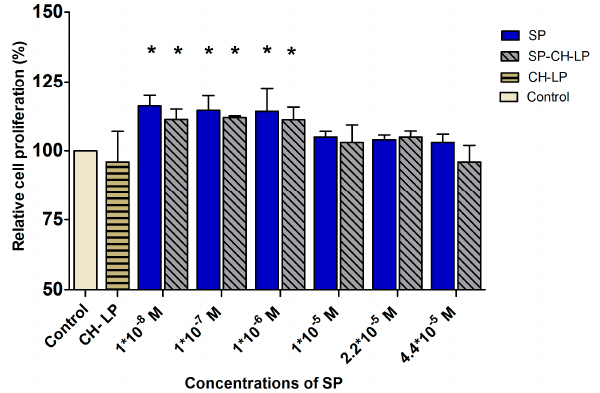
Figure 7. Effect of varying concentrations of free and liposome-encapsulated substance P on relative cell proliferation in HaCaT cells, as measured by BrdU colorimetric assay over 24 h. (Data represent the mean average ± standard deviation, of three independent biological experiments.) Cell culture medium (DMEM) with supplements was used as control; stars on bars represent significant differences with respect to the control by ANOVA with the Tukey multiple comparison test (* p < 0.05).